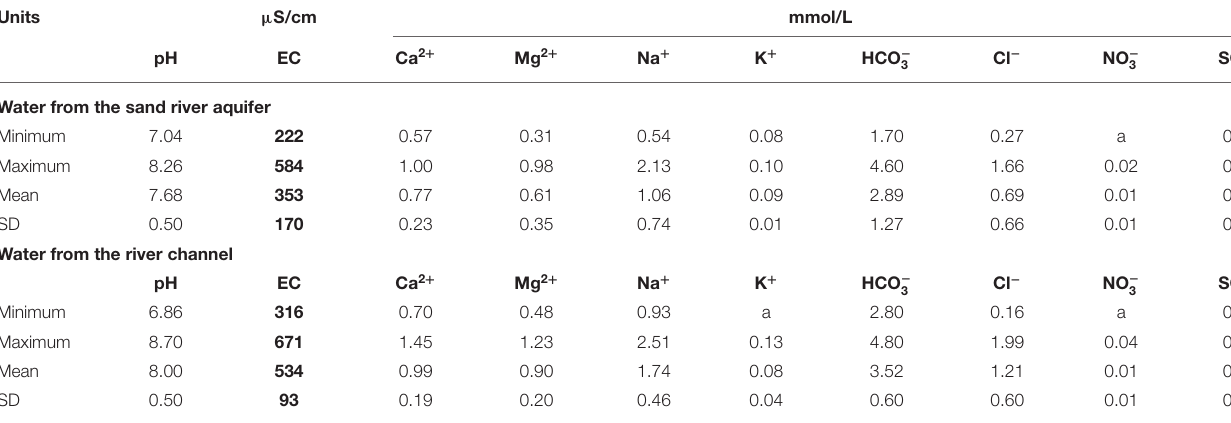
TABLE 3 | Descriptive statistical analysis of the chemical parameters of the sand river aquifer and the river water. Units µ